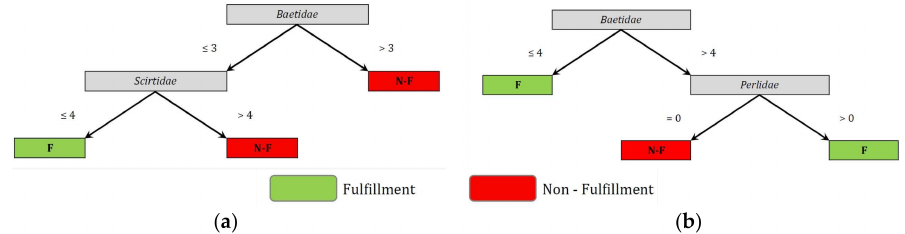
Figure 5. Macroinvertebrates abundance decision tree models (DTMs) in relation to fecal coliforms water use standard. Fulfillment of: ( a ) primary contact and ( b ) agriculture and livestock